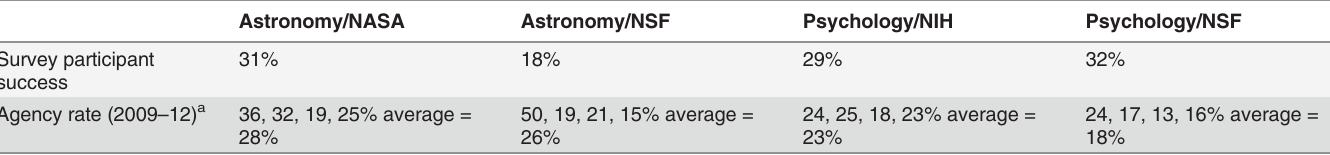
Table 3. Respondents ’ proposal success rates and agency funding rates, 2009 –